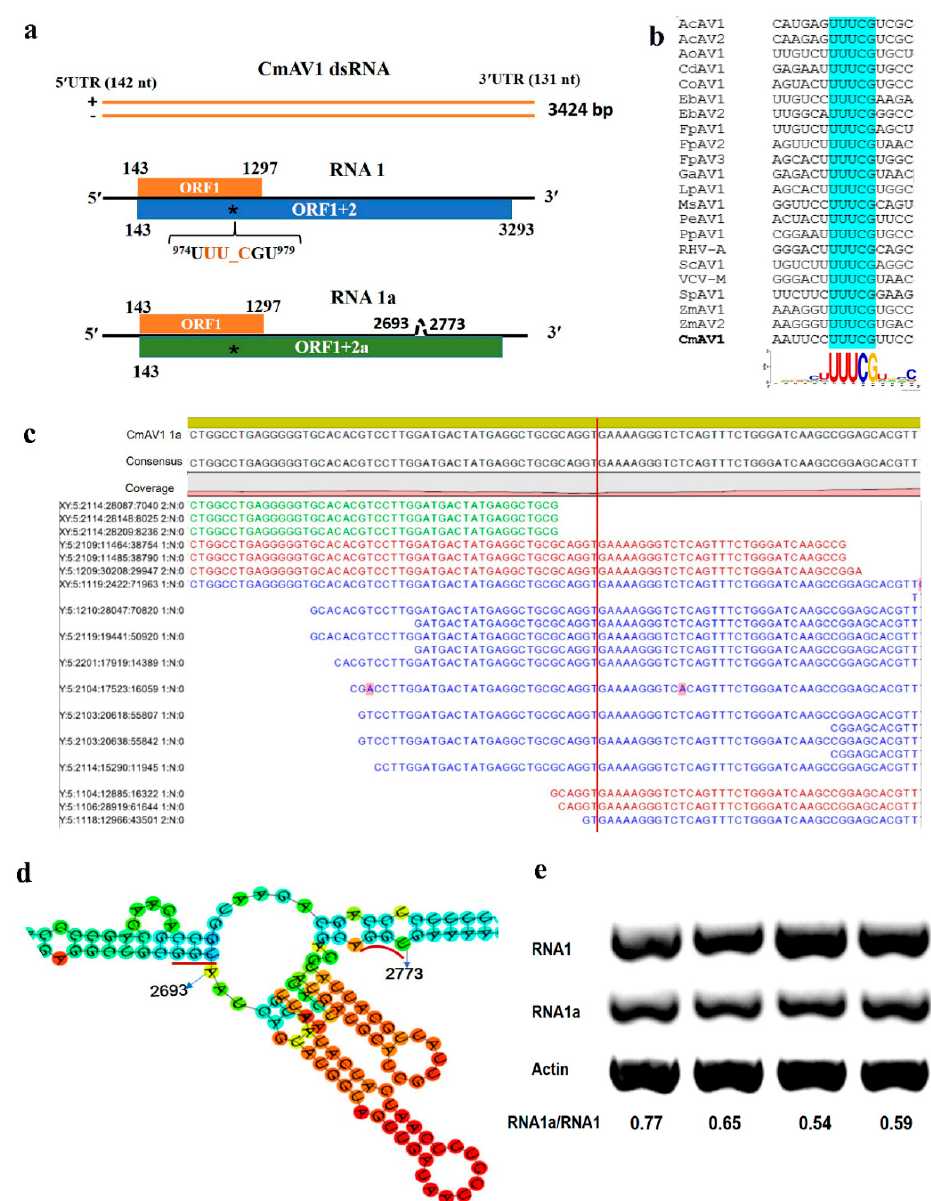
Figure 6. Schematic representation of the genome organizations of Cucumis melo amalgavirus 1 (CmAV1) ( a ) and the putative +1 programmed ribosomal frameshifting motif of CmAV1 ( b ). A sequence logo is presented at the bottom. ( c ) The segments that match the junction regions existed in the transcriptome dataset. ( d ) RNA structure of the deleted 2693–2773 region of RNA1 predicted by RNAfold in silico contained two hairpin structures. ( e ) The ratio of RNA1a to RNA1 in four leaves from different plants.